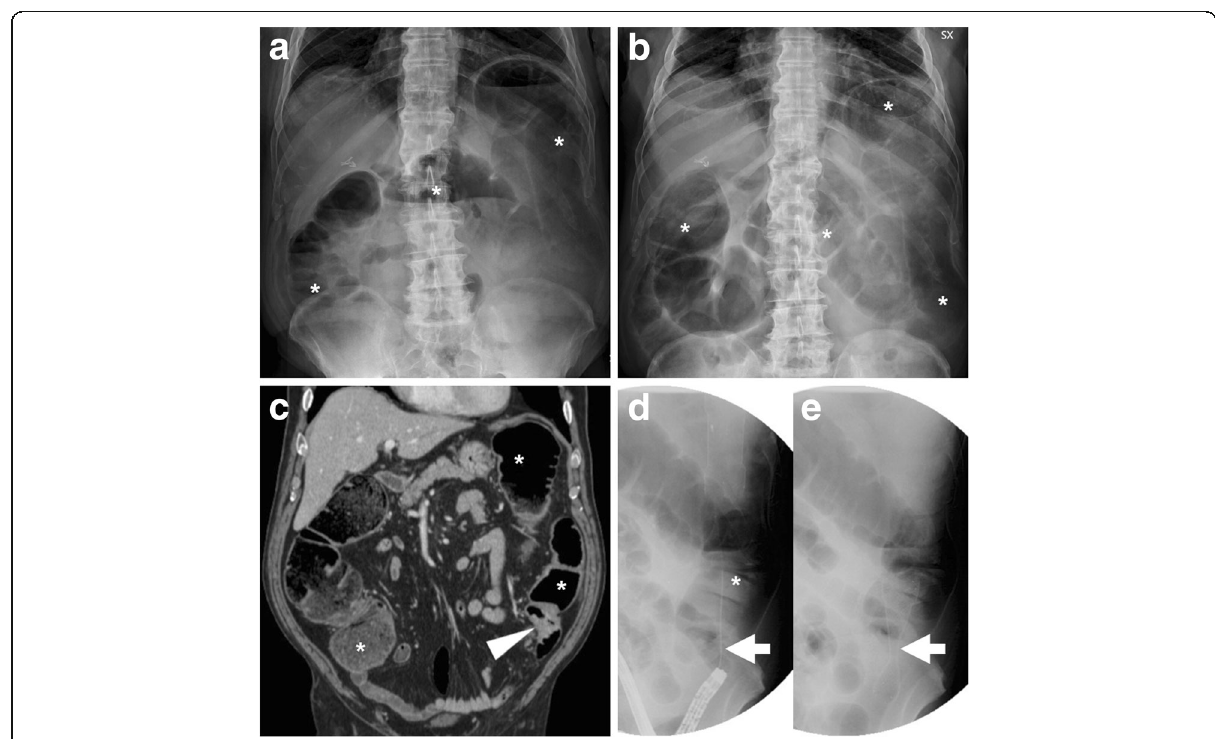
Fig. 6 “ Bridge-to-surgery ” stenting of obstructing CRC. Upright ( a ) and supine ( b ) plain abdominal radiographs show marked dilatation of the large bowel (*) with fluid-faecaloid material consistent with mechanical LBO (note air-fluid levels in a ). Coronal CT image ( c ) confirm colonic dilatation (*) above a 4-cm-long, solid mural thickening at the distal descending colon (arrowhead). After biopsy, fluoroscopic images documented the endoscopic positioning of a SEMS (thick arrow in e ) along the guidewire (thick arrow in d ) through the tumour. The patient then underwent left hemicolectomy with primary anastomosis to remove pT3N1G2